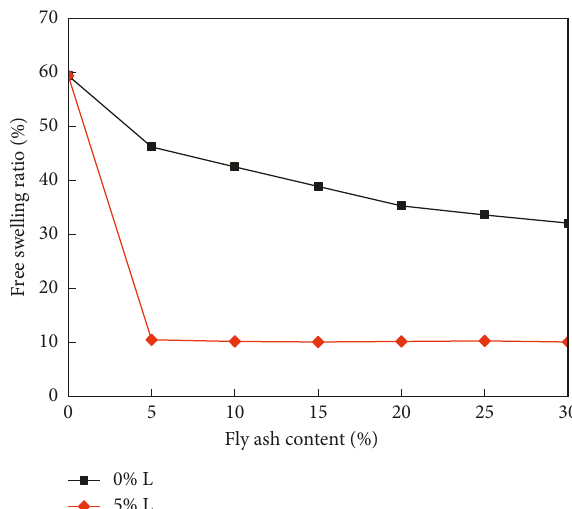
Figure 4: Variation laws of free swelling ratio under different fly ash and lime